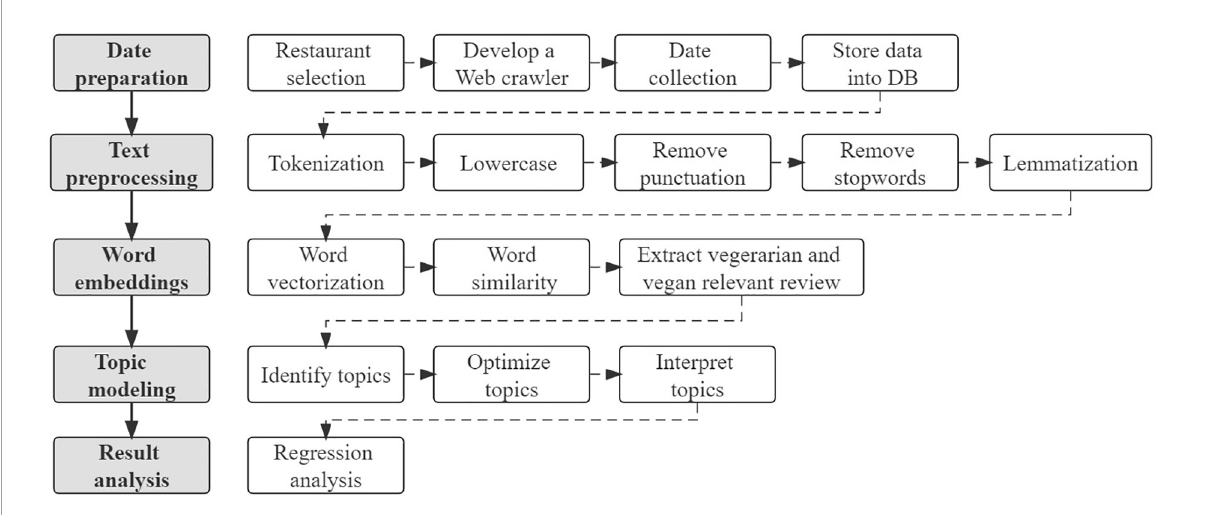
FIGURE1 Methodological